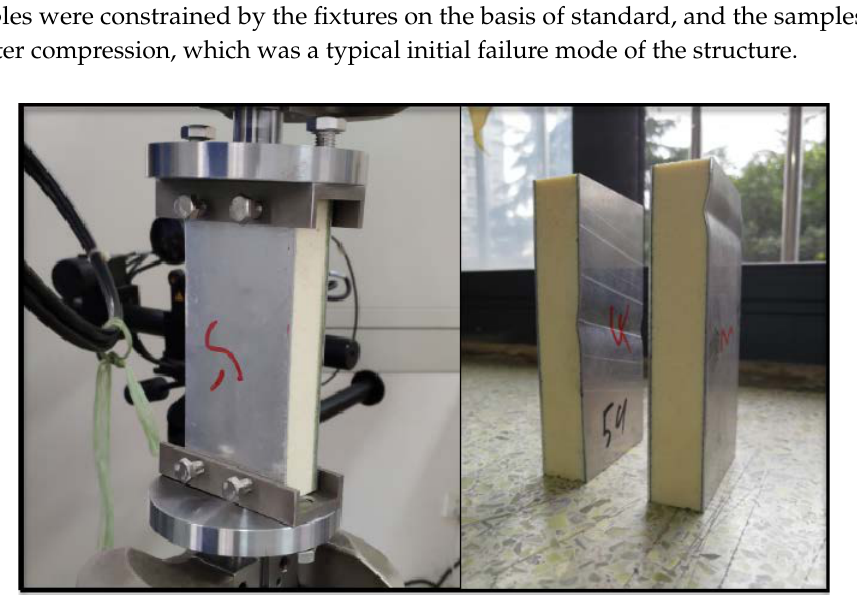
Figure 11. Edgewise compression test of sandwich plate and initial failure mode of buckling.